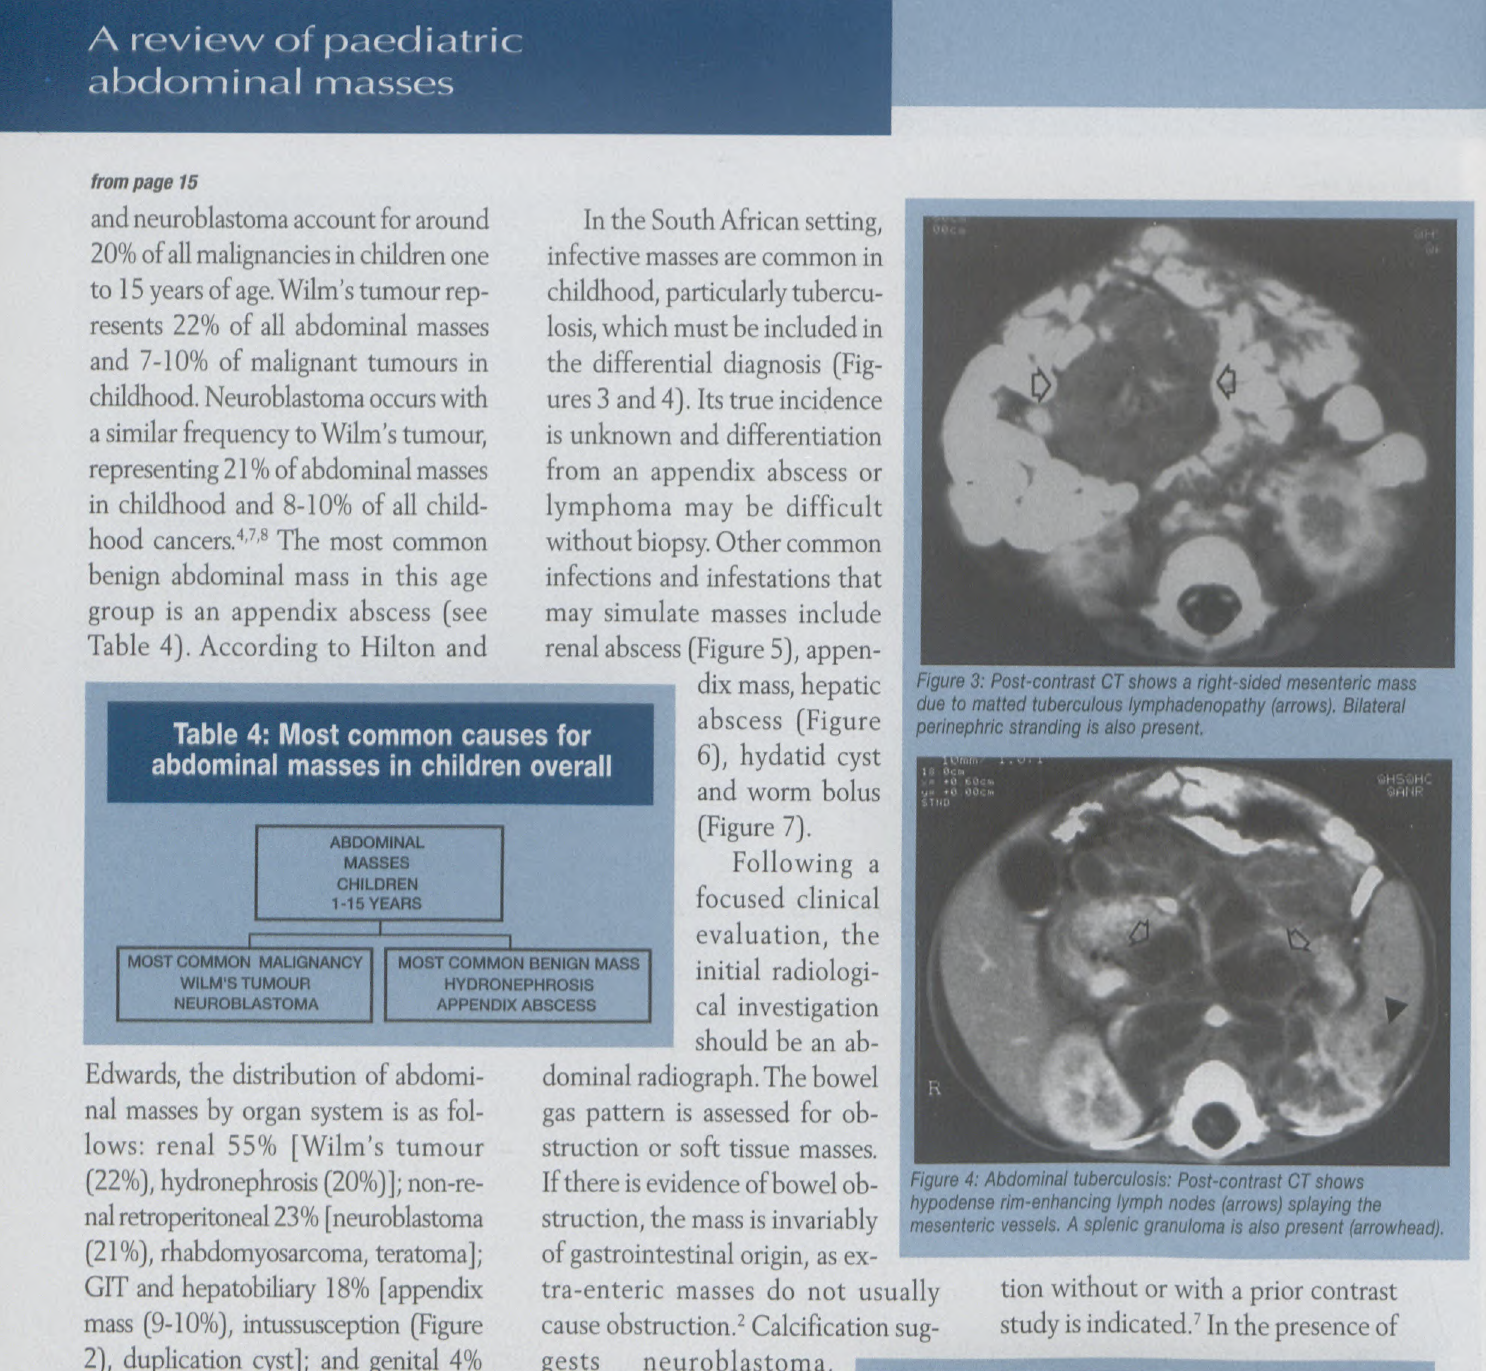
nium peritonitis (see Table 5).